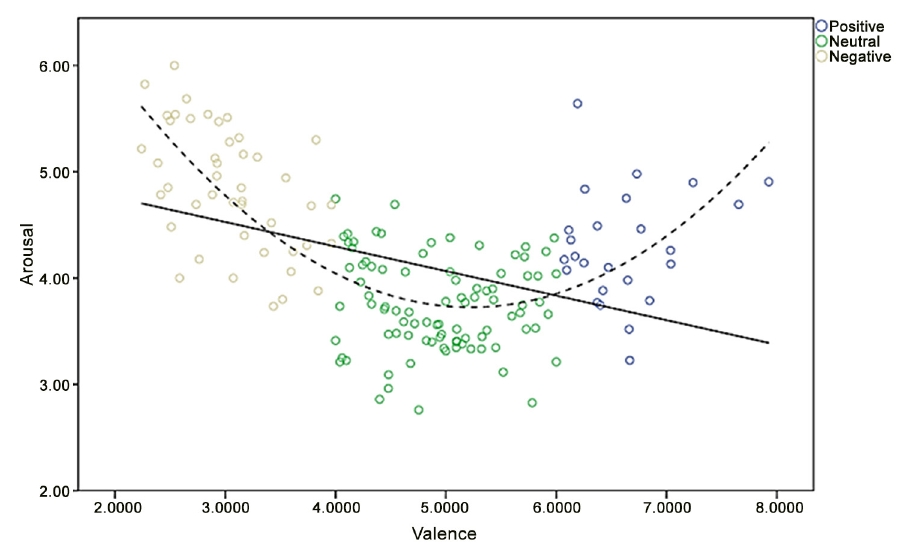
Fig 1. Distribution of the mean values (positive, negative, and neutral types of words) for the ratings of the 160 Chinese words in valence and arousal dimensions.